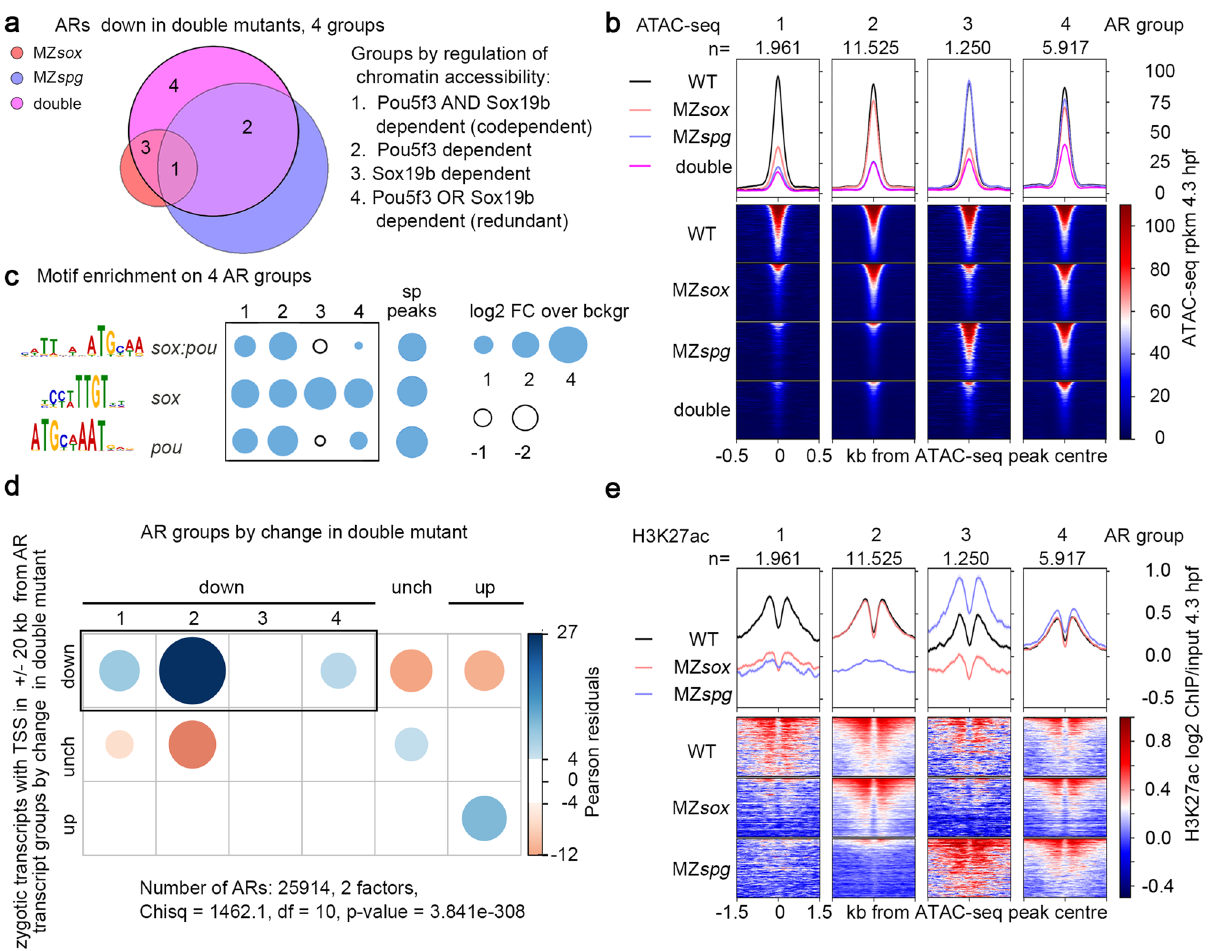
Fig. 7 Codependent, Pou5f3-dependent, and redundant cis-regulatory elements regulate the major ZGA wave. a Venn diagram: 20653 “ down ” ARs (regions where chromatin accessibility was reduced in the double mutant) were subdivided to groups 1 – 4 by reduction of chromatin accessibility in the single mutants. b ATAC-seq signals on AR groups 1 – 4 in the wild type, single and double mutants. ARs were sorted by descending ATAC-seq peak score. c Enrichment for sox:pou , sox and pou motifs in AR groups 1 – 4 compared to the regions bound by Pou5f3 and SoxB1 (sp peaks). d Chi-squared test. Codependent(1), Pou5f3-dependent (2), and redundant (4) ARs, but not Sox19b-dependent ARs, are enriched around Transcription Start Sites (TSS) of zygotic genes, downregulated in MZ sox19bspg double mutant. P -value is two-tailed. e H3K27ac on 4 AR groups depends on the same TFs as accessibility (compare with ATAC-seq in b ). (1) codependent ARs: Pou5f3 and Sox19b are required for H3K27ac, (2) Pou5f3-dependent ARs: Pou5f3 is required for H3K27ac, (3) Sox19b-dependent ARs: Sox19b is required for H3K27ac, (4) redundant ARs: any factor is suf fi cient for H3K27ac, no reduction in the single mutants. ARs were sorted by descending ATAC-seq peak score. MZ sox = MZ sox19b , double = MZ sox19bspg , n number of regions in each group. Source data for a – c , and e are provided as a Dataset S3. Source data for c are provided as Dataset S4. Source data for d are provided as Dataset